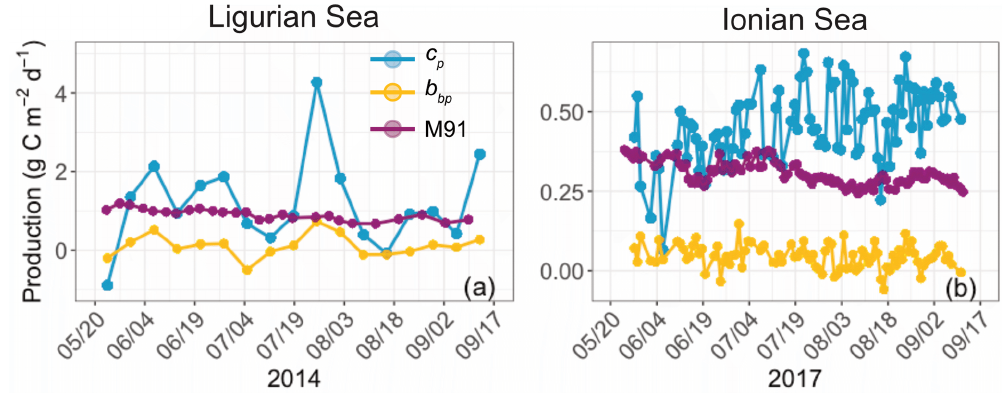
Figure 6. Comparison of the biological production integrated within the euphotic layer, derived from the diel cycle of c p (blue) or b bp (yellow) or computed using the bio-optical primary production model of Morel (1991) (M91; purple) for the Ligurian Sea (a) and the Ionian Sea (b) . Please note that the date format in this figure is month/day.